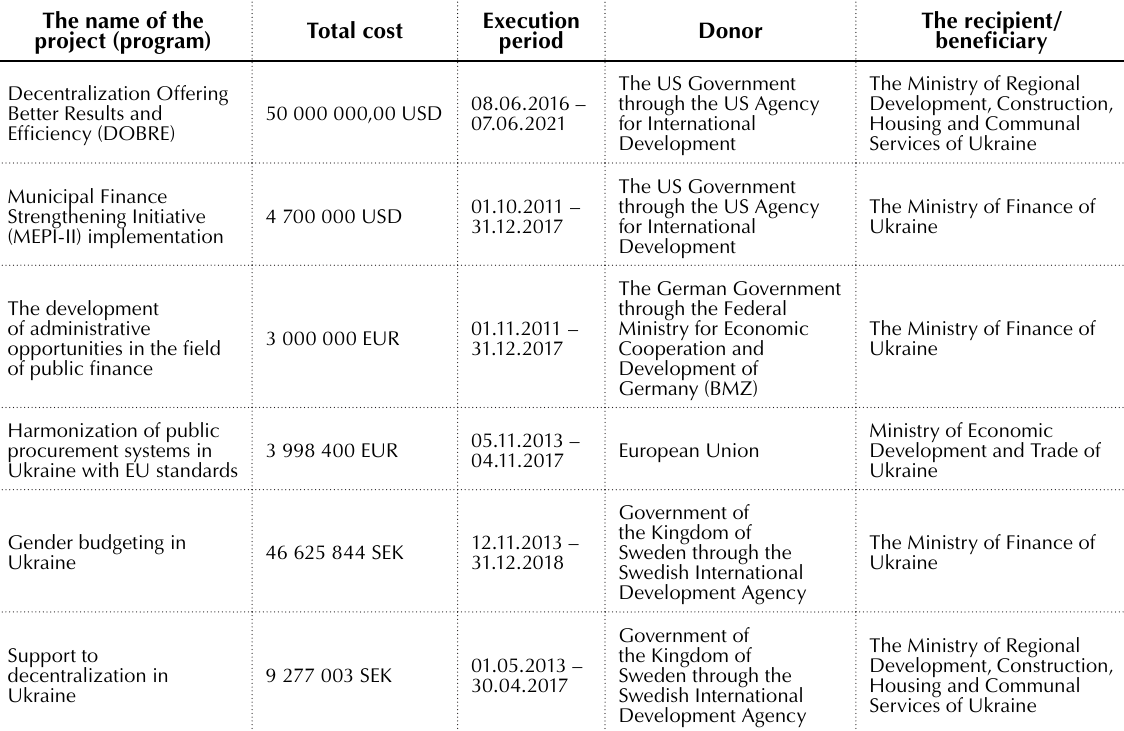
Table 1. Exis�ng innova�ve projects and public financial management moderniza�on program in Ukraine The name of the project